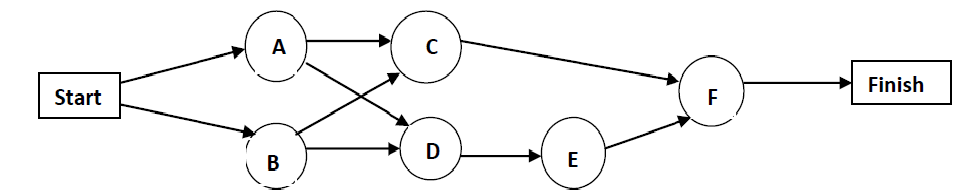
Fig. 1. Network diagram of the